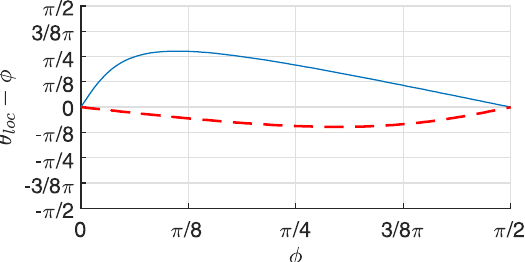
Figure 6. H ( θ ) for uniaxial compression in y -direction